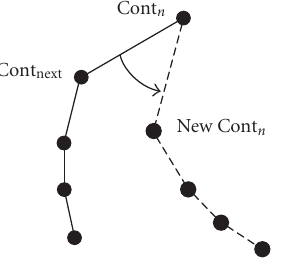
Figure 13: The template segments before (solid line) and after (dashed line) rotation, during ear contour